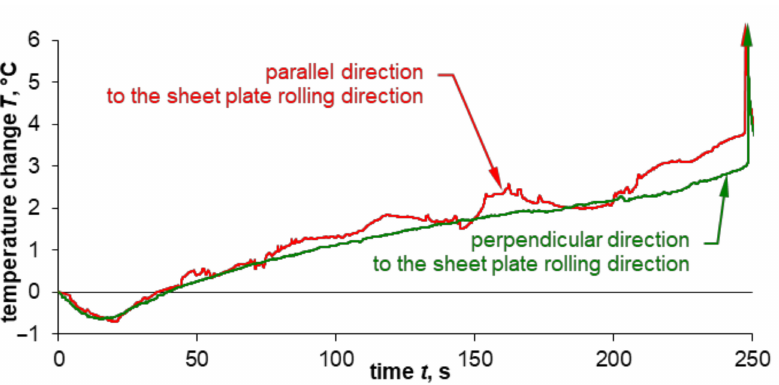
Figure 9. The summary of the temperature change course for specimens cut out of 0.16” thick 2024-T3 sheet plate parallel and perpendicular to the rolling